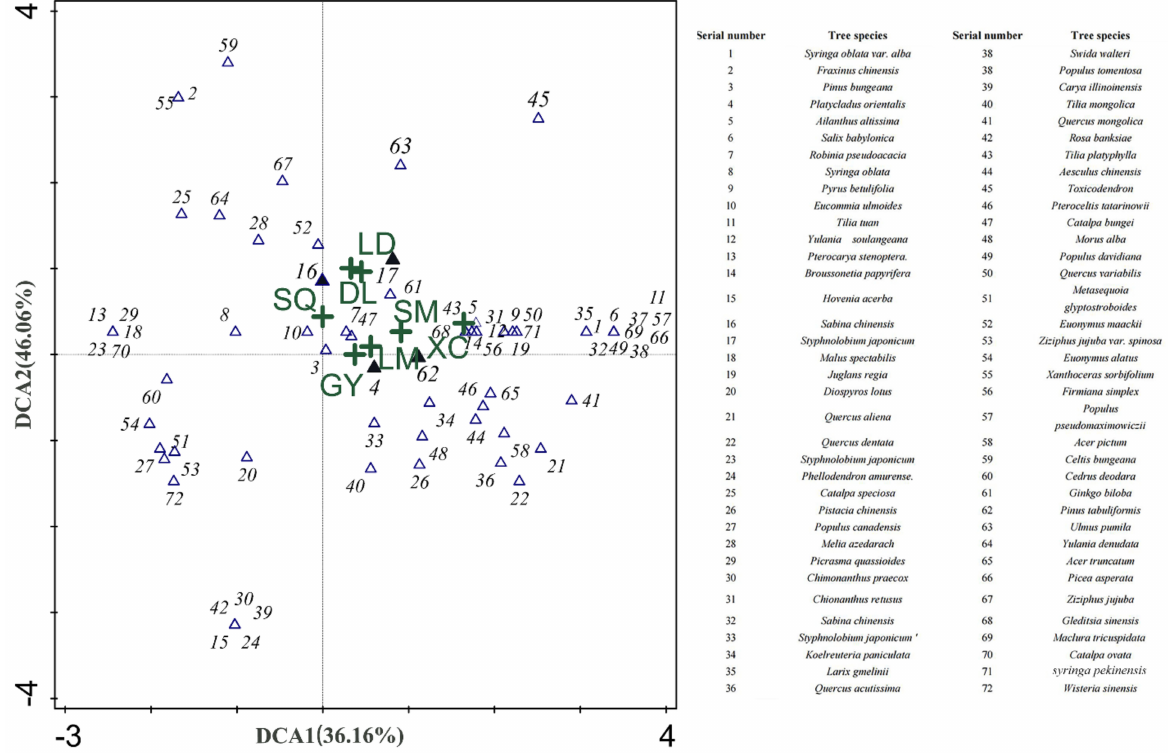
Figure 3. Species-habitat DCA results (Note: Cross marks represent different habitats (refer to Table 2); see the table to the right for tree